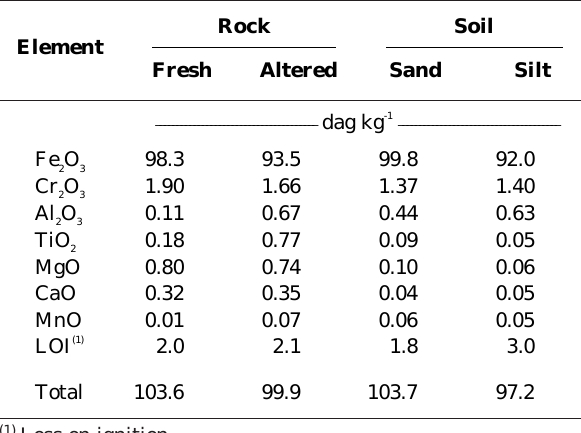
Table 1. Chemical composition of magnetic fractions of fresh and altered rocks, sand 7xCBD and silt